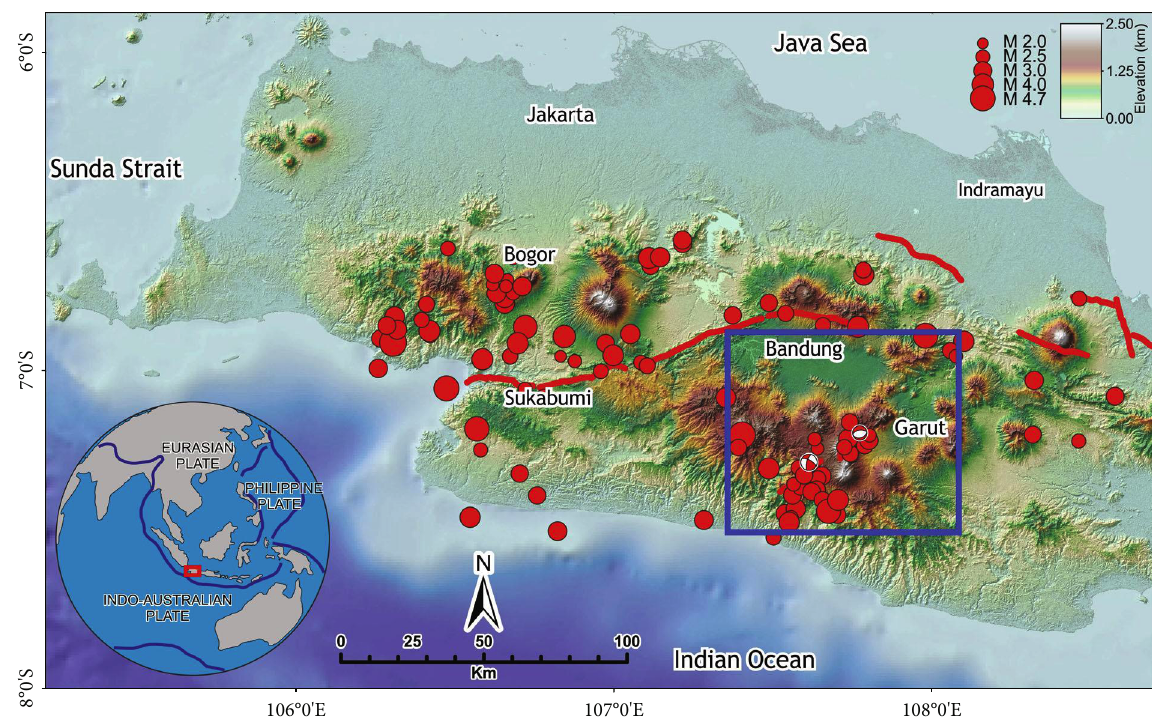
Figure 1: Location of the study area in southern Garut, West Java, Indonesia, indicated by the blue box, along with the relocated shallow earthquakes from 2009 to 2015 [1], destructive earthquakes represented by focal mechanisms [2], and active fault traces